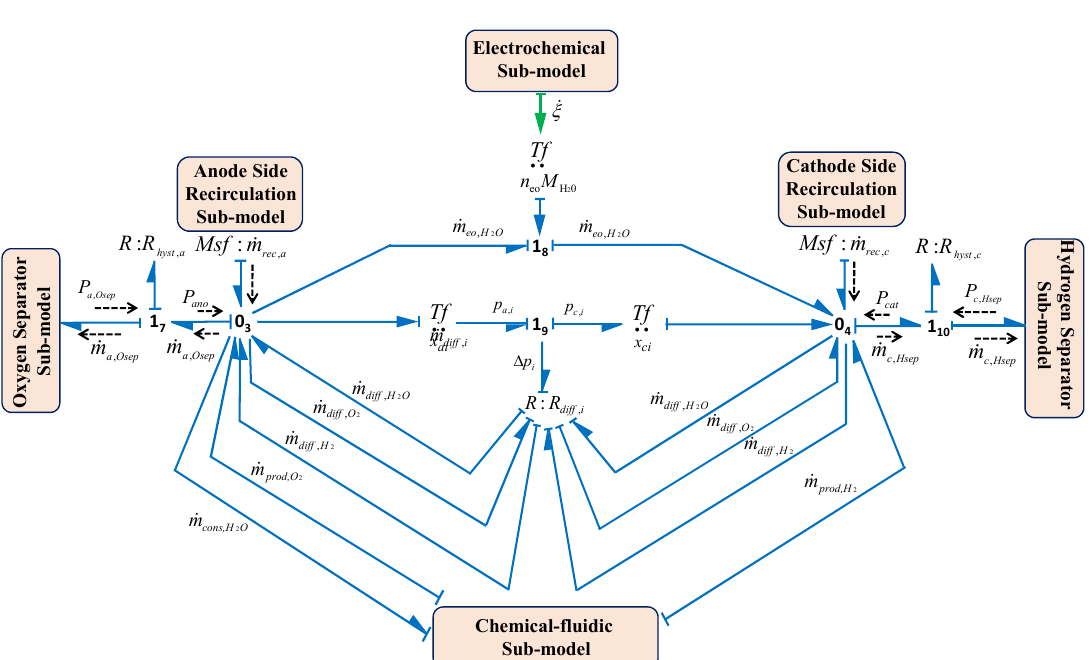
Figure 12. BG sub-model of fluidic and mass transfer phenomenon in capsule